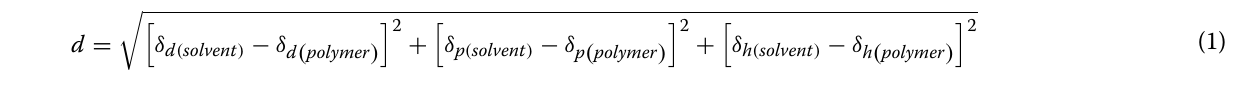
Table 1 Physical properties and cost of non-toxic solvents